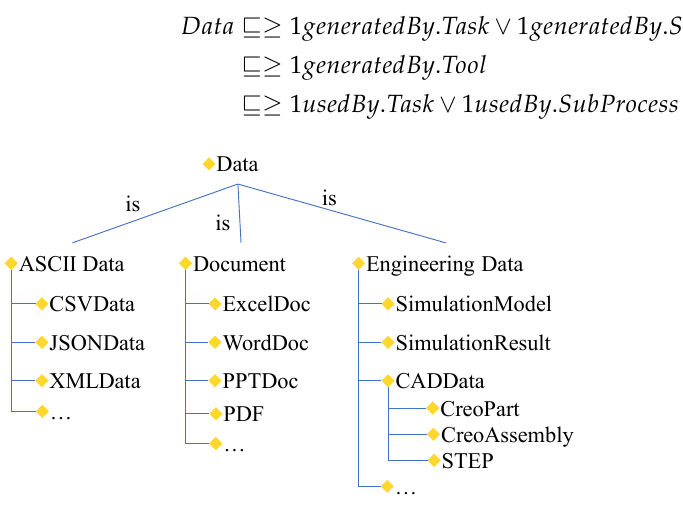
Figure 6. Specification of the data concept (yellow diamonds symbolise core